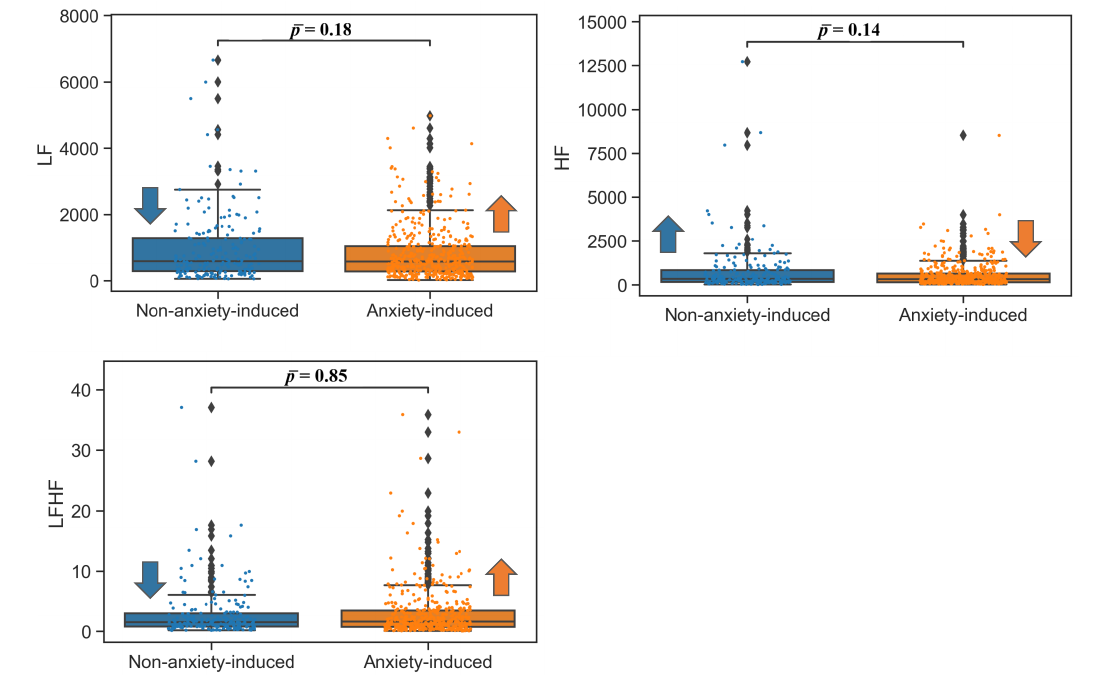
Figure 2. Box plots of frequency domain ECG features in nontransitional video phases. Low frequency: LF [ms 2 ]; high frequency: HF [ms 2 ]. Arrows indicate which of the two populations (non-anxiety-induced state or anxiety-induced state) had a higher (upward arrow) or lower (downward) value for ease of visualization.